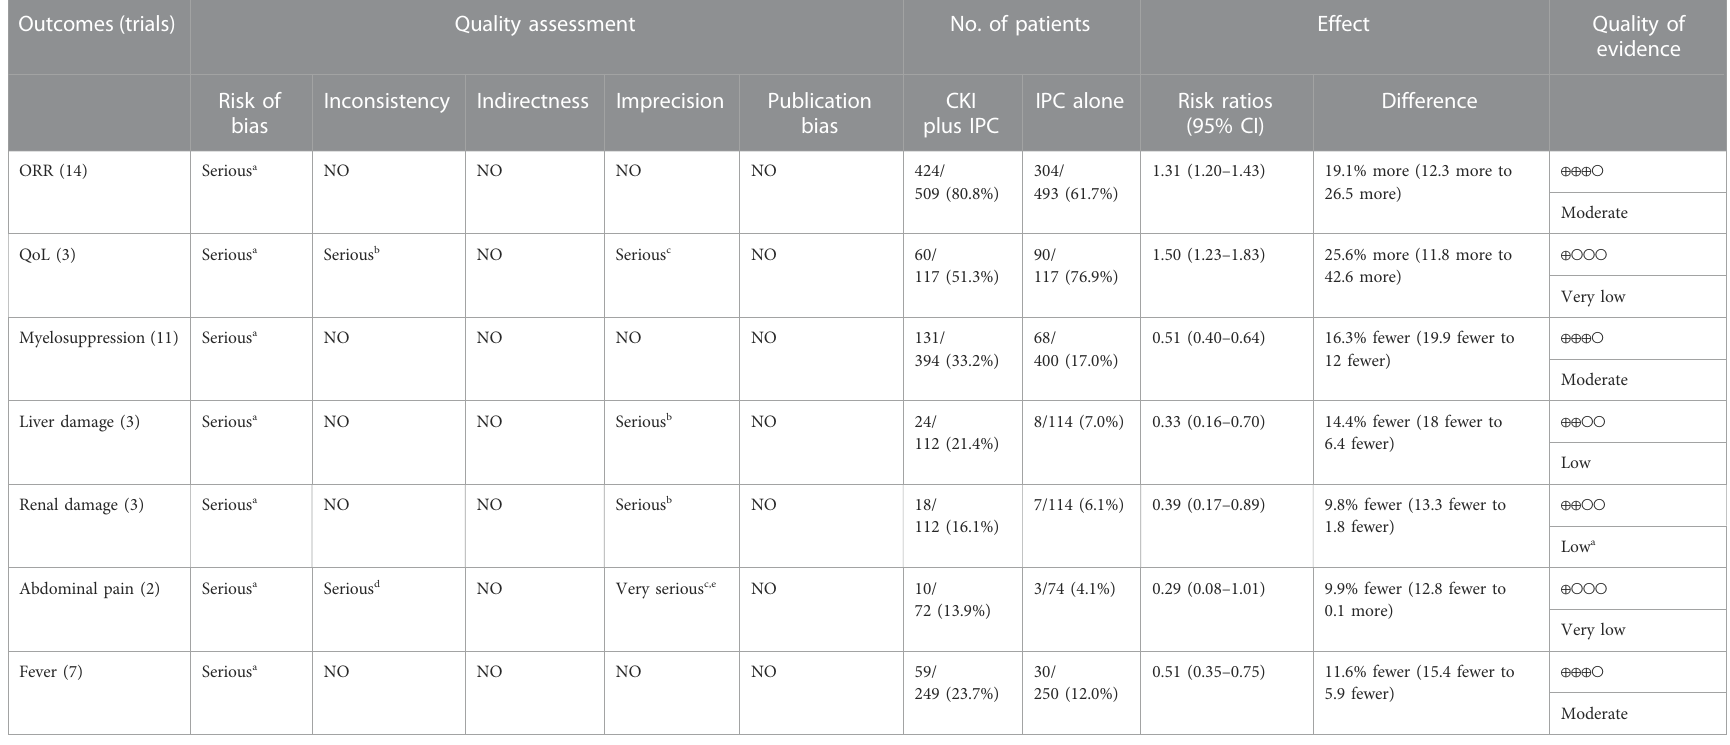
TABLE 4 GRADE evidence pro fi le of clinical ef fi cacy and